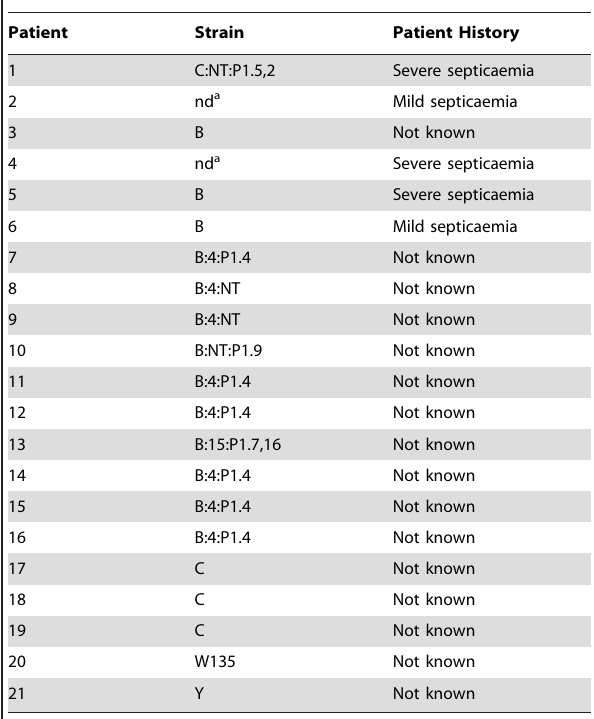
Table 1. Details of patient sera.